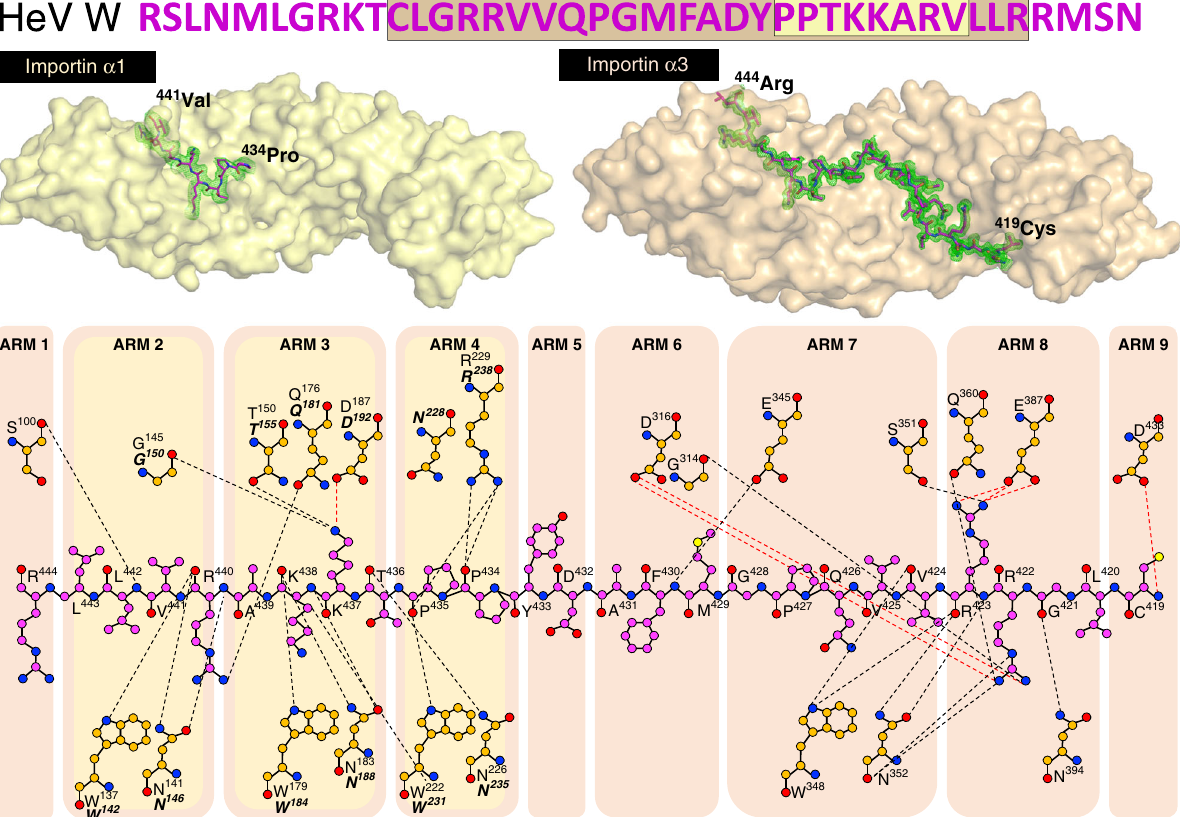
Fig. 2 Structural comparisons and basis for high af fi nity interaction of HeV W with importin α 3. Importin α 1:HeV W and importin α 3:HeV W structures were solved to 2.2 Å and 1.6 Å resolution, respectively. The importin α adaptors are shown in cartoon and surface representation (importin α 1: bright yellow, importin α 3: light orange) and HeV W NLS in stick representation (magenta: carbon atoms, red: oxygen atoms, blue: nitrogen atoms) with associated simulated annealing Fo-Fc omit maps of the NLSs contoured to 3 σ in green. Schematics of the binding interface and speci fi c interactions are shown below (magenta: carbon atoms, red: oxygen atoms, blue: nitrogen atoms), with hydrogen bond and salt bridge interactions depicted by dash lines (black and red respectively), and the partner interactions for importin α 1 (bold italics) and importin α 3 coloured as orange: carbon atoms, red: oxygen atoms, blue: nitrogen atoms. The location of these interactions in the ARM repeats highlight the greater interaction interface of the HeV W NLS for the importin α 3